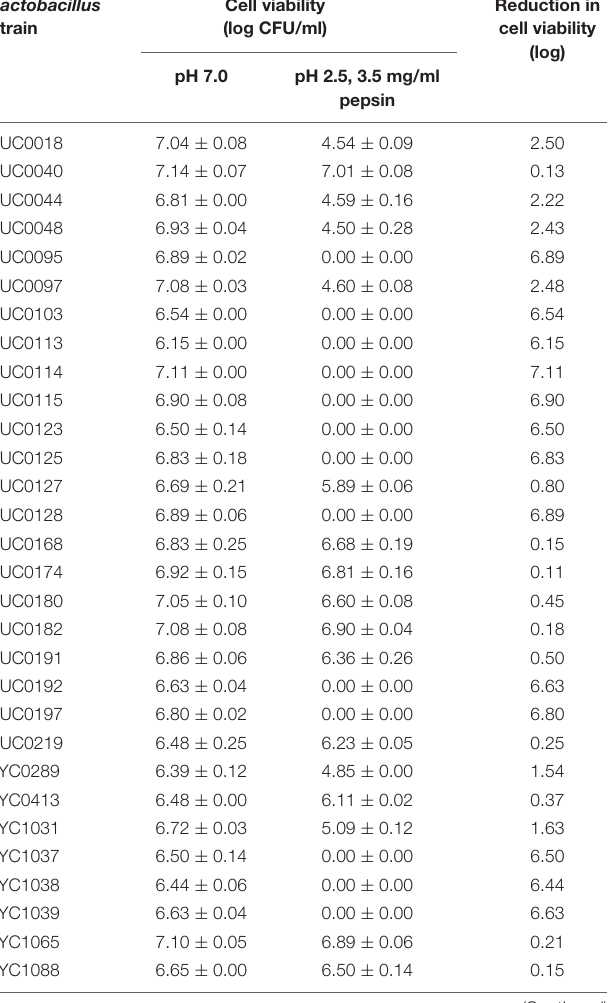
TABLE 3 | Pepsin tolerance test results for 57 Lactobacillus isolates at pH 2.5 with 3.5 mg/ml pepsin. Lactobacillus strain